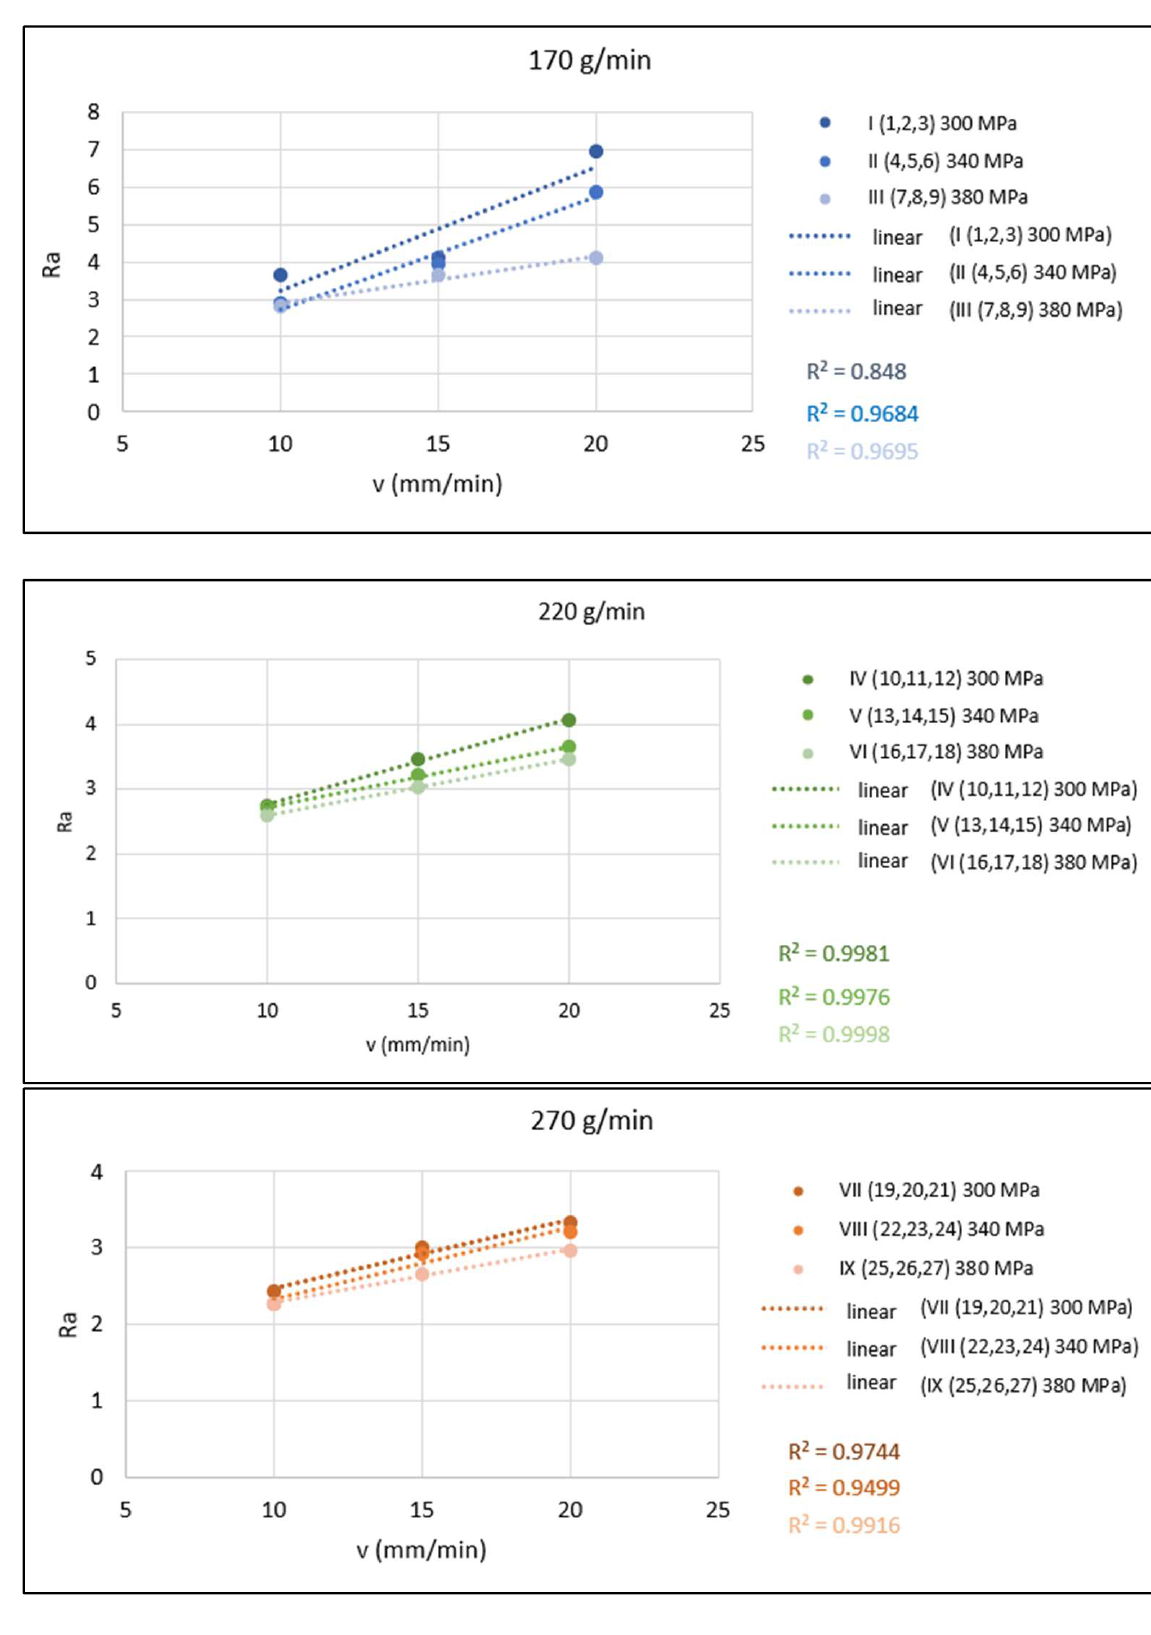
Figure 6. Graphical evaluation of 1-parametric dependences of Ra = f( v ) for m A = 170, 220 and 270 g/min.